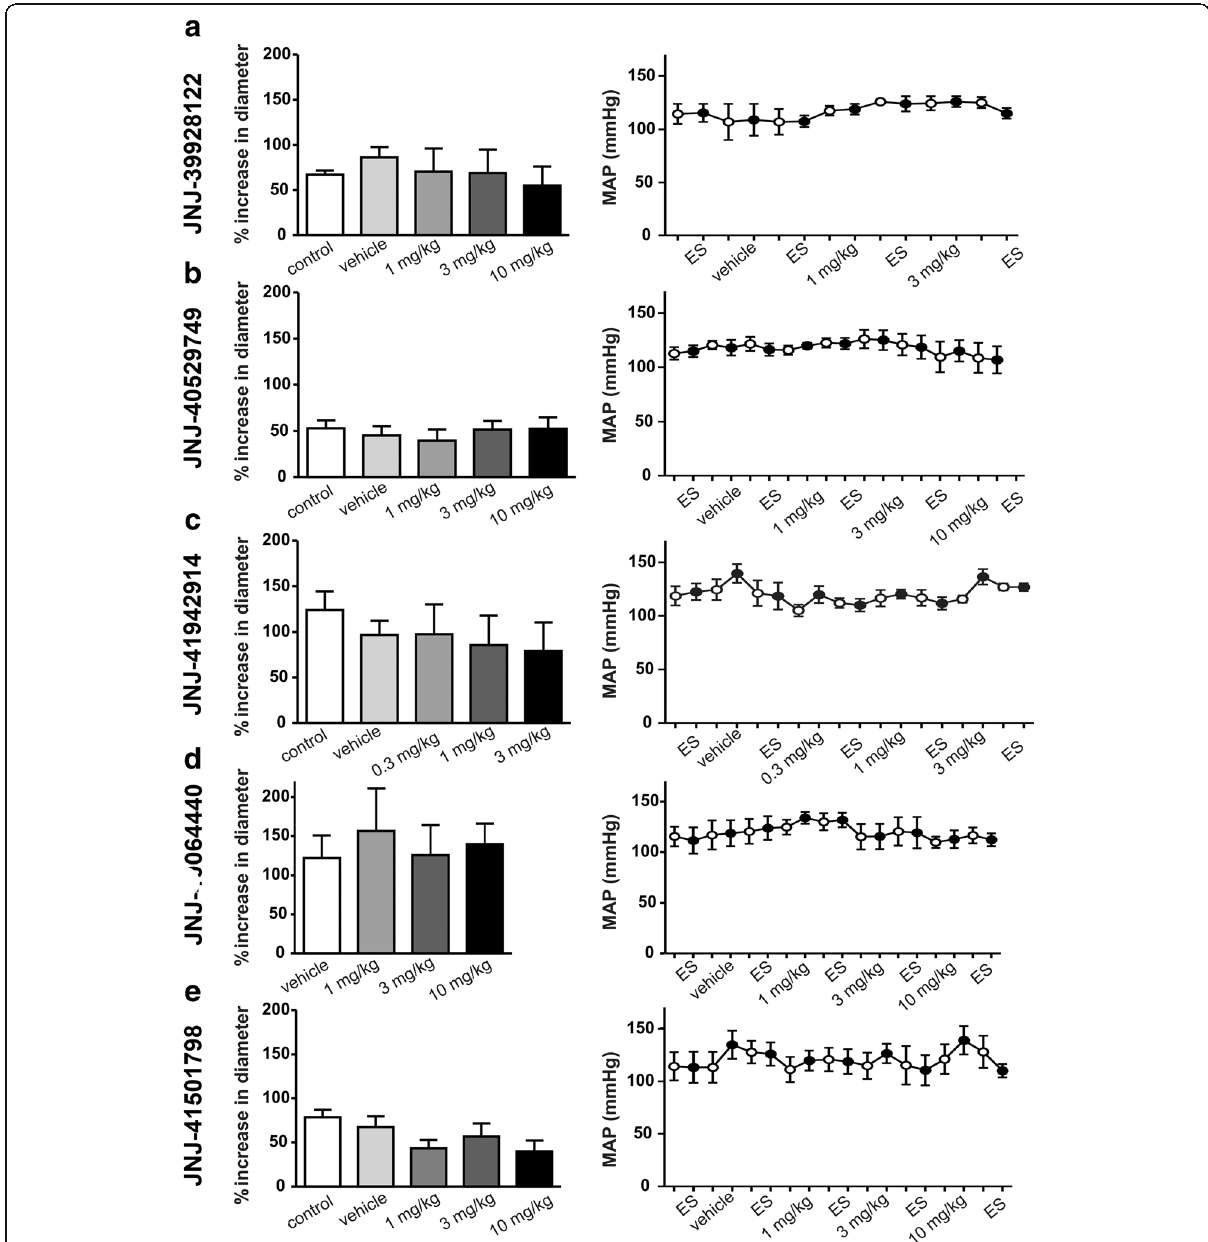
Fig. 3 Effect of A 2A antagonists on perivascular electrical stimulation of the dural artery. Perivascular electrical stimulation (150 – 250 μ A) in the absence or presence of vehicle, or varying doses of JNJ-39928122 (A, n = 4), JNJ-40529749 (B, n = 4 – 5), JNJ-41942914 (C, n = 6), JNJ-40064440 (D, n = 4), or JNJ-41501798 (E, n = 7 – 8). Data are presented as percentage of increase in diameter, left panels) and changes in mean arterial blood pressure (mm Hg, right panels) induced by periarterial electrical stimulation (ES). Note that none of the treatments produced any significant changes ( p > 0.05 compared to the vehicle). Open circles represent baseline measurements before injections/ES. JNJ-40064440 was dissolved